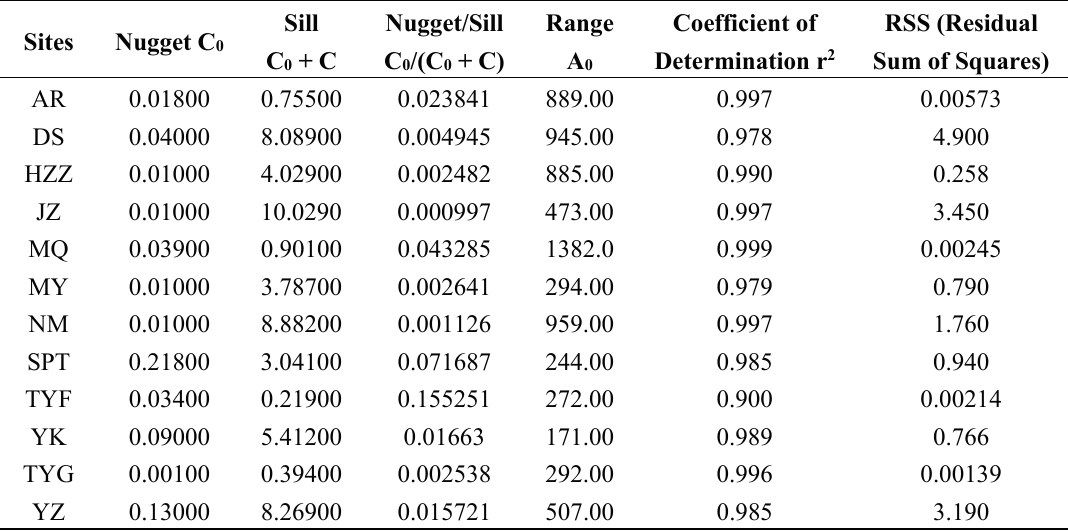
Table 4. Summary of the variogram